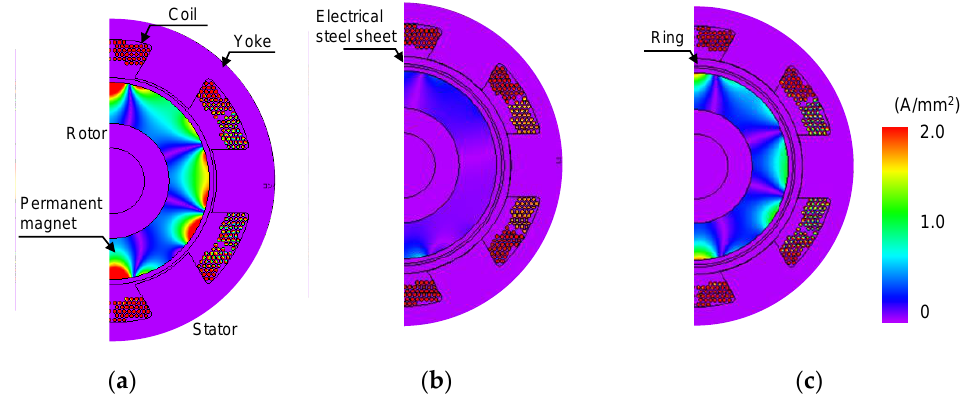
Figure 8. Current density distributions ( N = 30,000 rpm, P o = 500 W): ( a ) open-slot motor, ( b ) closed-slot motor, and ( c ) ring motor.